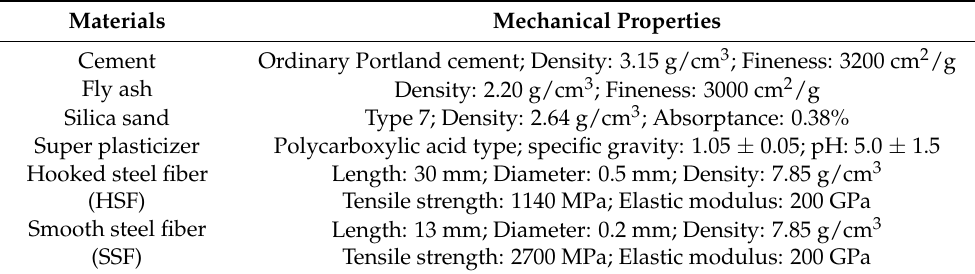
Table 2. Mechanical properties of the used materials.